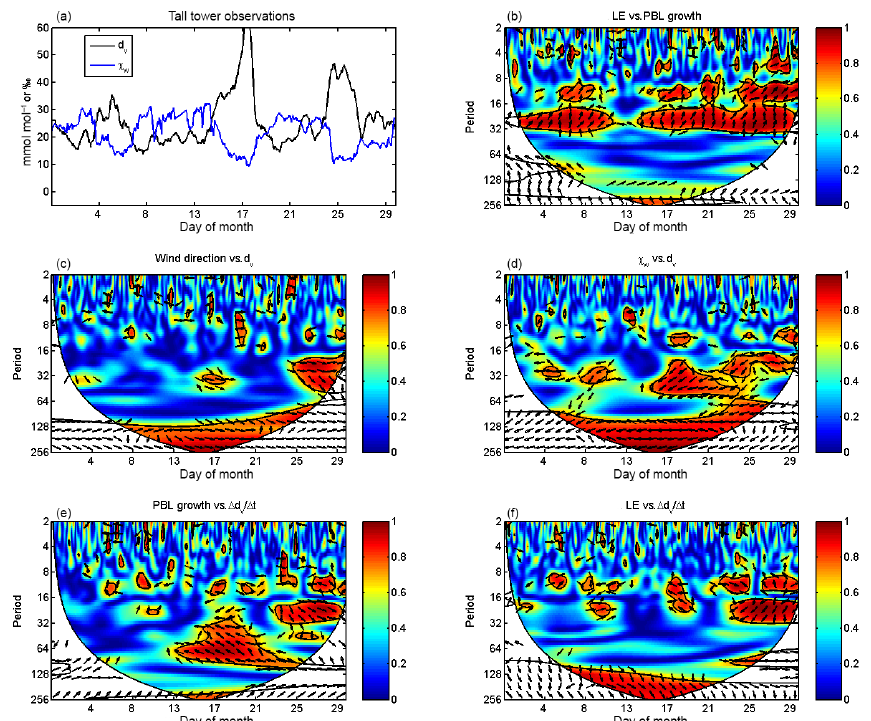
Figure 6. Wavelet coherence analysis of deuterium excess ( d x ) for August 2010. Hourly observations of water vapor mixing ratio and deuterium excess from the tall tower 185m sample level (a) . Wavelet coherence of evaporation vs. PBL growth (b) . Wavelet coherence of wind direction vs. PBL growth (c) . Wavelet coherence of water vapor mixing ratio vs. deuterium excess (d) . Wavelet coherence of PBL growth vs. the time derivative of deuterium excess (e) . Wavelet coherence of evaporation vs. the time derivative of deuterium excess (f) . The color bar represents the local correlation coefficients in time–frequency space. The period is shown in hours. The black arrows represent the phase angle relationship between the variables. Arrows pointing east and west show signals that are in perfect phase and antiphase, respectively. Arrows pointing north show that variable 1 leads variable 2 (defined in figure titles) by a phase shift of 90